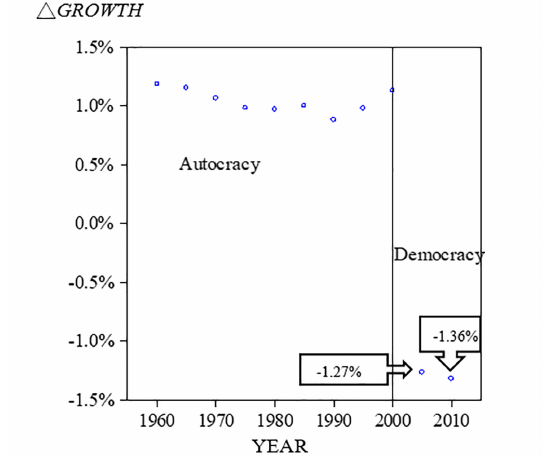
Figure 2. Scatter plot of Δ GROWTH and PSTOCKL for